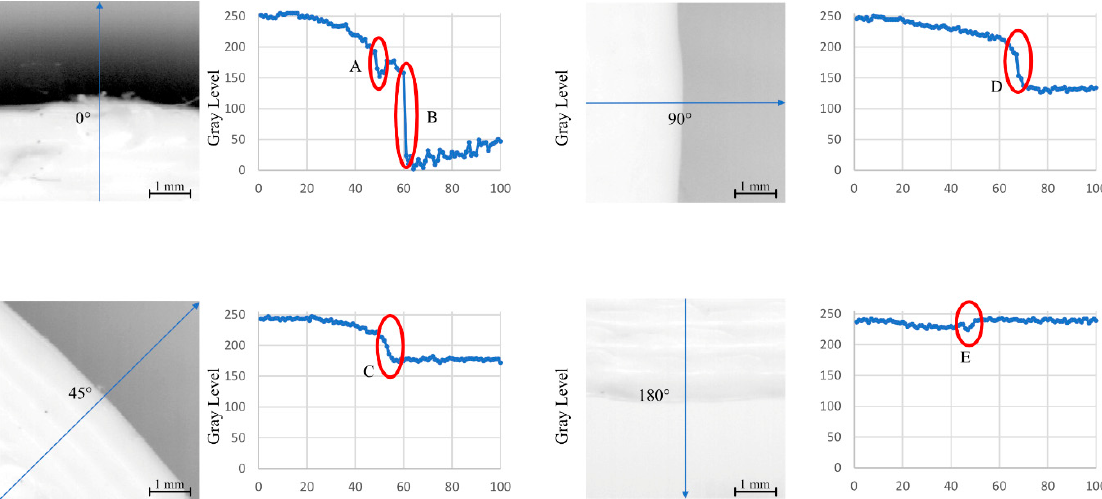
Figure 17. Linear samples of grey-level intensity distribution in the original scan of 𝑆03 for different orientations: 0° (top